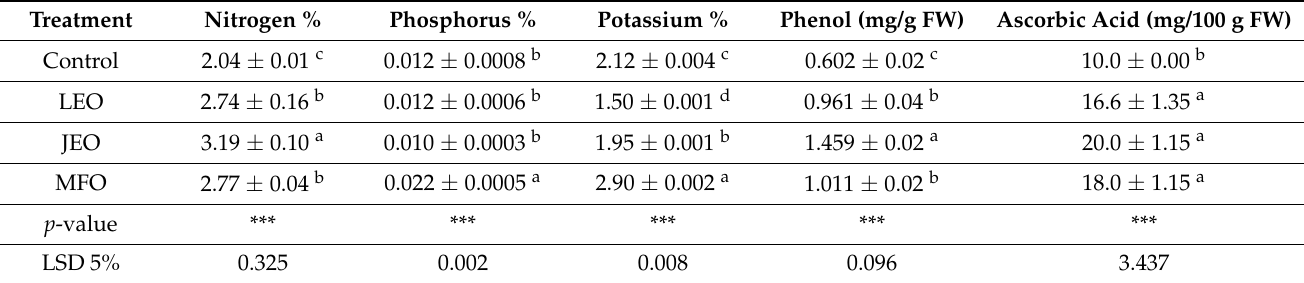
Table 4. The effect of foliar application with jasmine and lavender essential oils or mustard fixed oil on the ion percentage and concentration of phenols and ascorbic acid of eggplant growth under TSSM natural infestation in a controlled greenhouse.